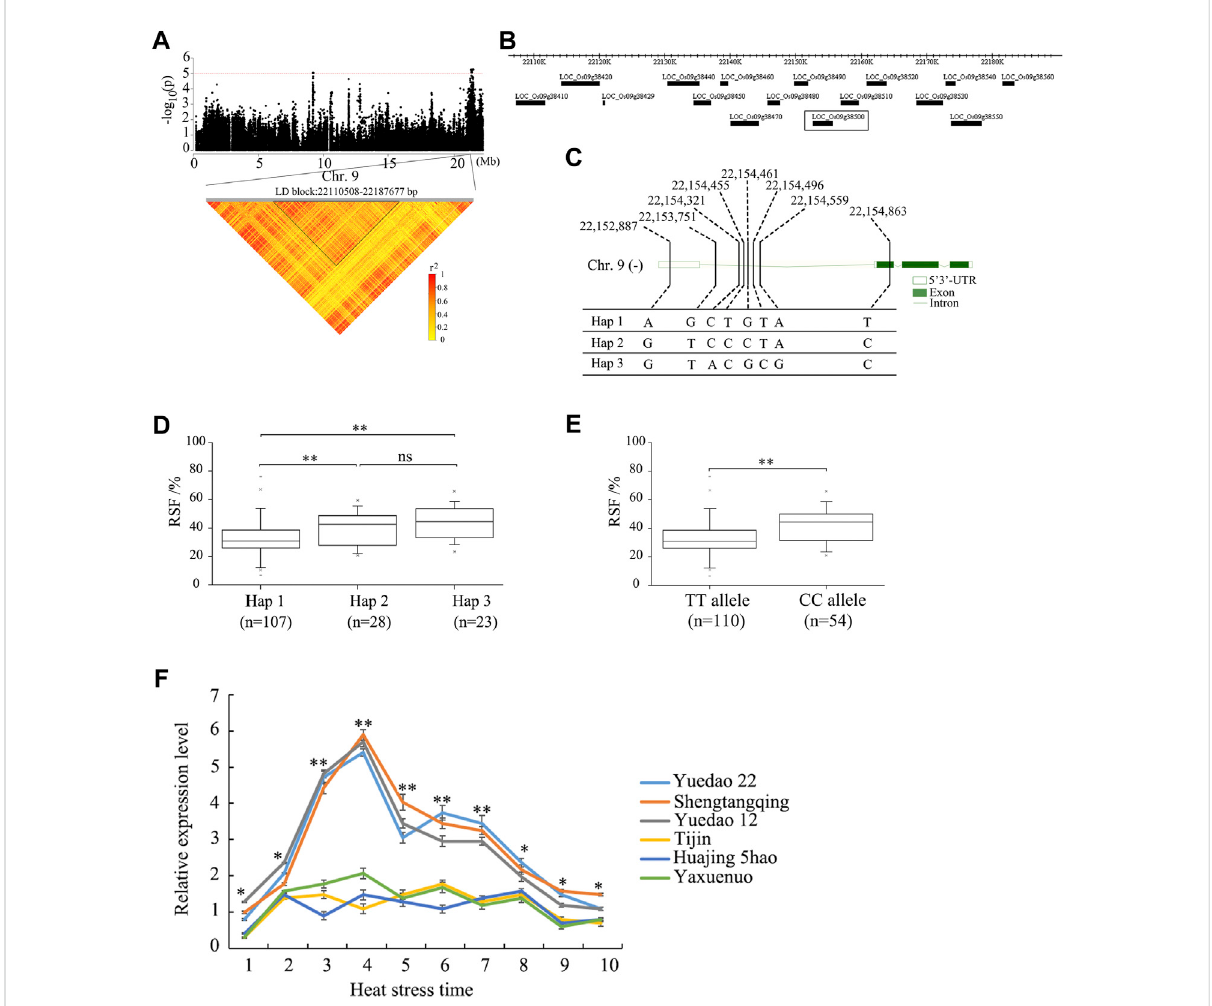
FIGURE 4 Identi fi cation of the candidate genes for the QTL qRSF9.2 for relative spikelet fertility as determined by integrated analyses of GWAS and gene expression datainrice. (A) Identi fi cationofthehaplotypeblockof qRSF9 .2. Y axismeansnegativelog 10 transformed p -valuesanddotsabovethered line show the signi fi cant SNPs in the QTL region. Pairwise LD was determined by calculation of r 2 (the square of the correlation coef fi cient between SNPstates). (B) Identi fi cationofcandidategenesintheregionof qRSF9.2 . (C) Haplotypesof LOC_Os09g38500 associatedwithrelativespikelet fertility in rice. (D, E) Box-plots of relative spikelet fertility in accessions containing the different haplotypes (D) and elite alleles (E) . (F) Expression analysis of candidate gene LOC_Os09g38500 in different materials under heat stress for various time periods. The relative expression values were normalized to the rice UBQ gene. The error bars indicate standard deviation, and asterisks indicate signi fi cant differences using the Student ’ s t -test (* p < 0.05,** p < 0.01).Numbers1-10on X